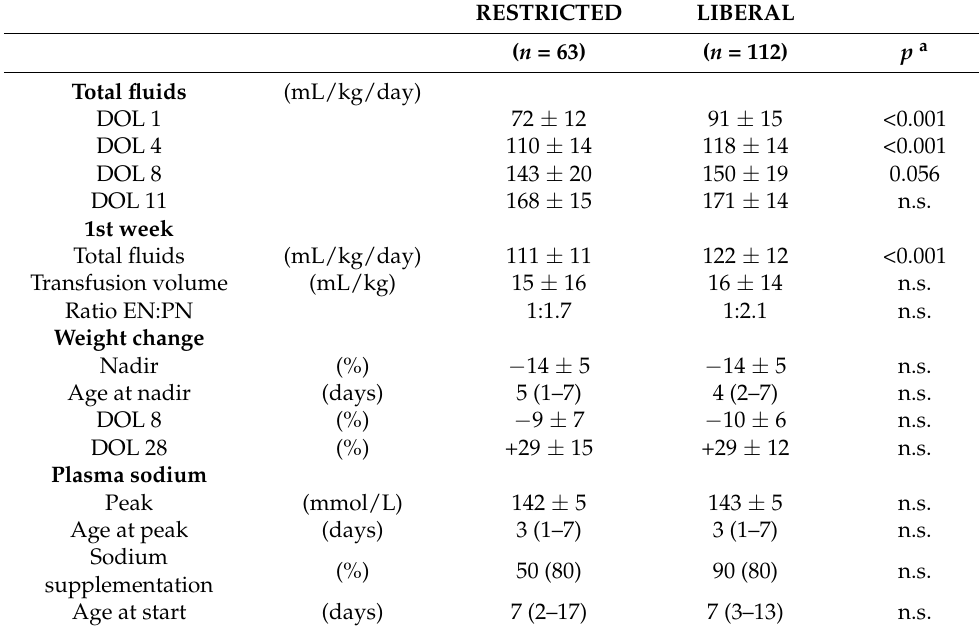
Table 2. Fluid volumes, weight change, and plasma sodium.